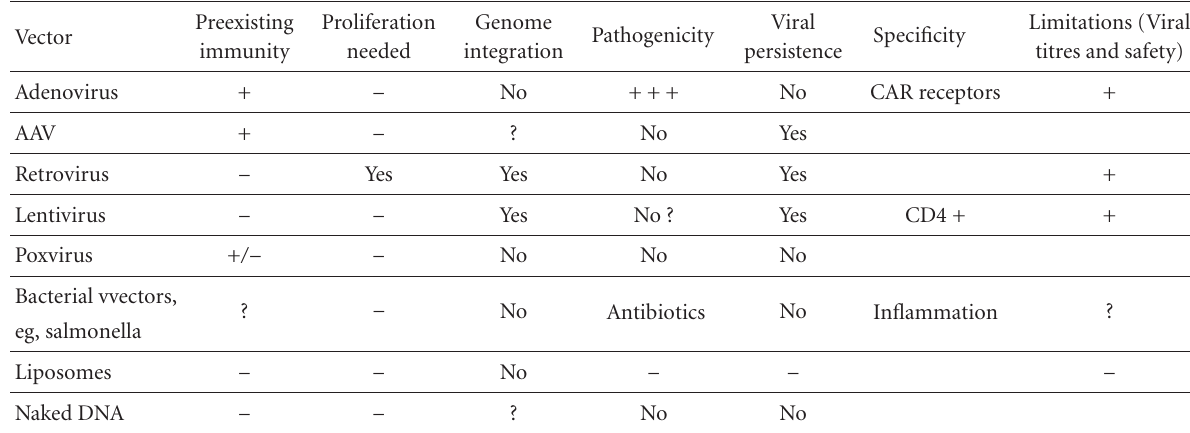
Table 1. Gene therapy